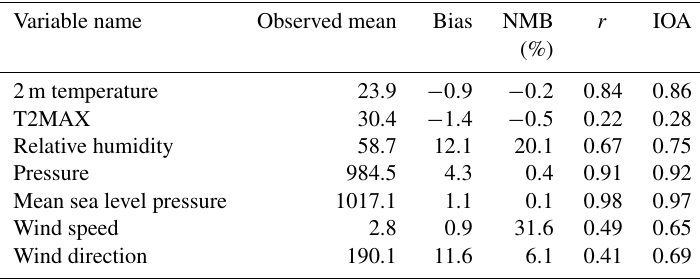
Table 3. Observed mean and simulation summary statistics for meteorological parameters. The bias, normalized mean bias (NMB), corre- lation coefficient ( r ), and index of agreement (IOA) are calculated between simulated and observed meteorological parameters at the DWD stations during the 1–8 August 2018